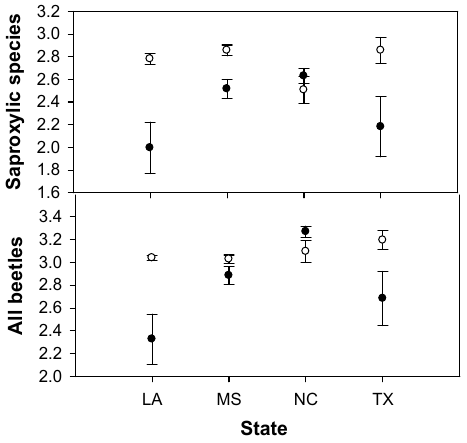
Figure 3. Mean ± SE ( n = 3) saproxylic (top) and total (bottom) beetle diversity (Shannon’s diversity) in reference and dead wood plots (closed and open circles, respectively) by state in 1998.